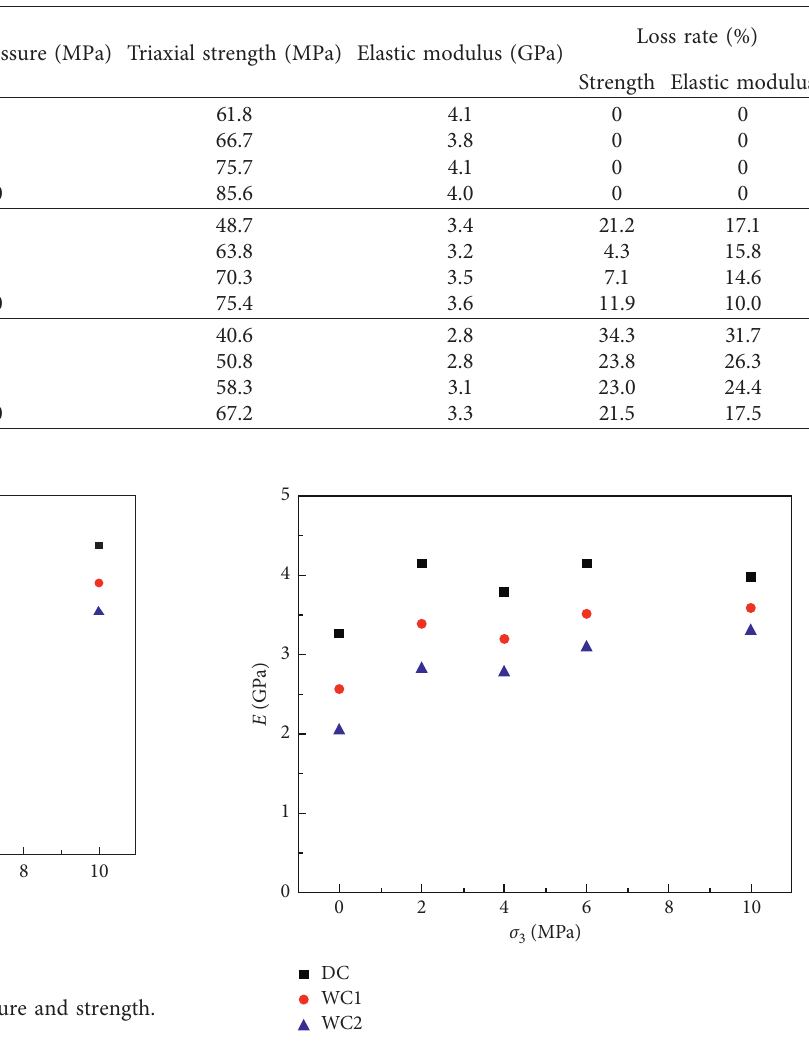
Figure 9: Relation between confining pressure and elastic